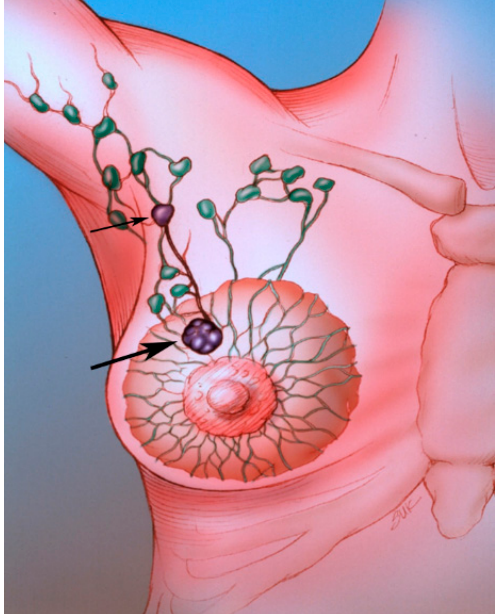
Figure 2. The SLN (small arrow) is the first lymph node draining the tumor (large arrow).